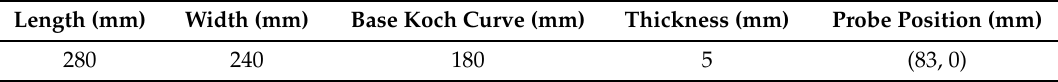
Table 3. Final design